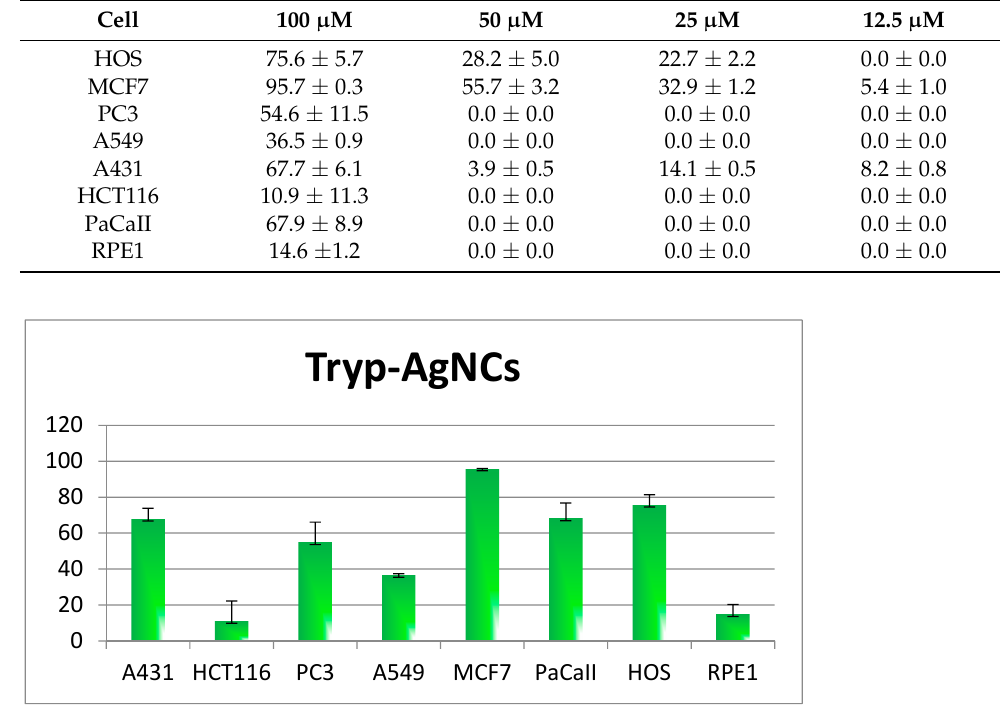
Figure 8. The activity of Tryp-AgNCs on the different tumor cell lines. Table 4. IC 50 (µM) of Ag-Try on human tumor cell lines.